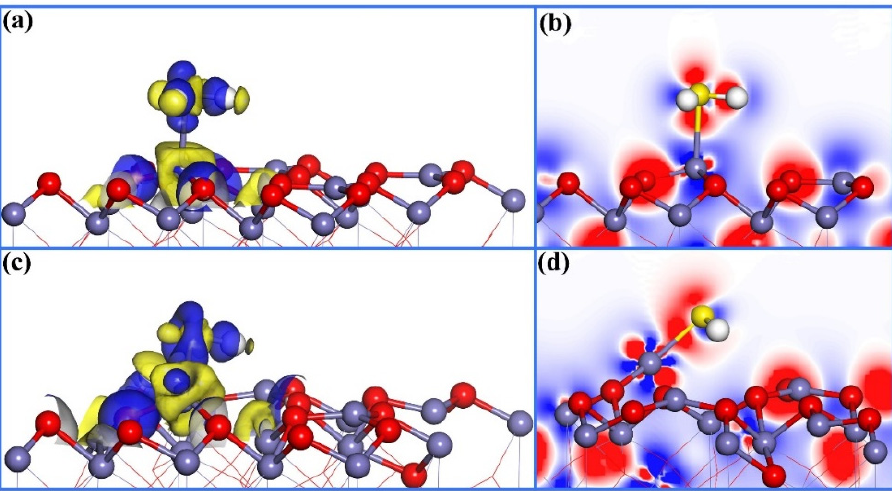
Figure 6. ( a ) The PDOS of Fe atoms on the pure and vacant α -Fe 2 O 3 (001) surface before adsorption; ( b ) the PDOS of pure α -Fe 2 O 3 (001) surface of Fe atom and S atom of H 2 S after adsorption; and ( c ) the PDOS of Fe atom and S atom of H 2 S on the surface of the adsorbed vacancy α -Fe 2 O 3 (001).